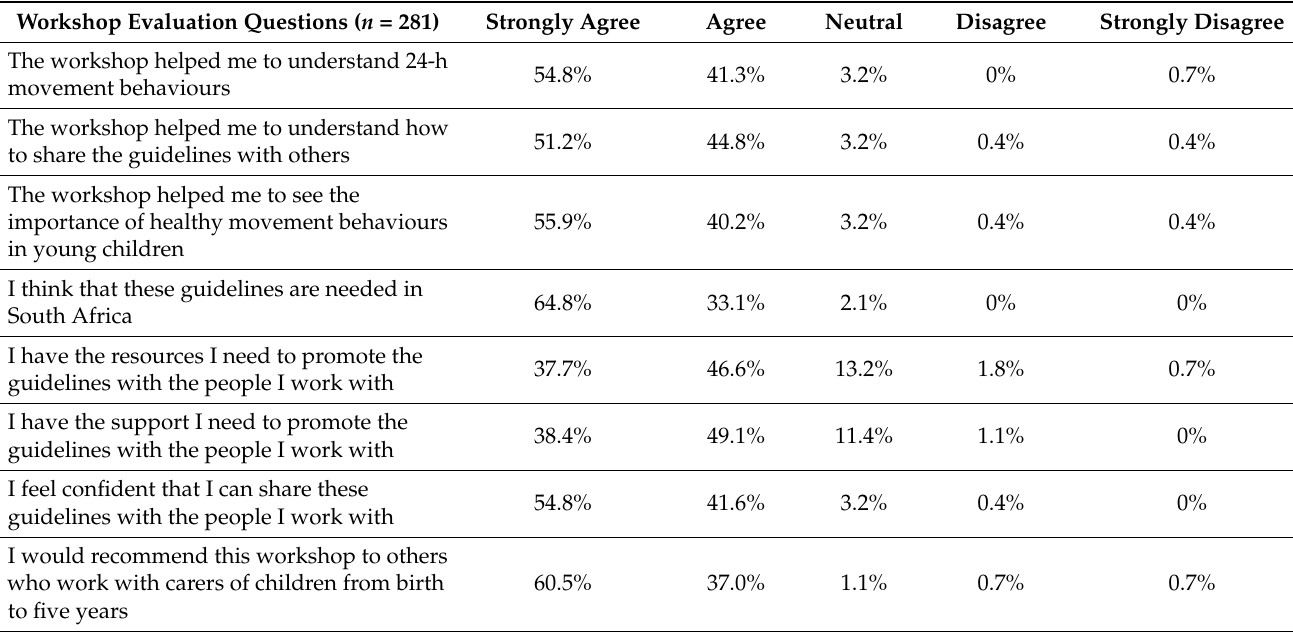
Table 3. Workshop evaluation